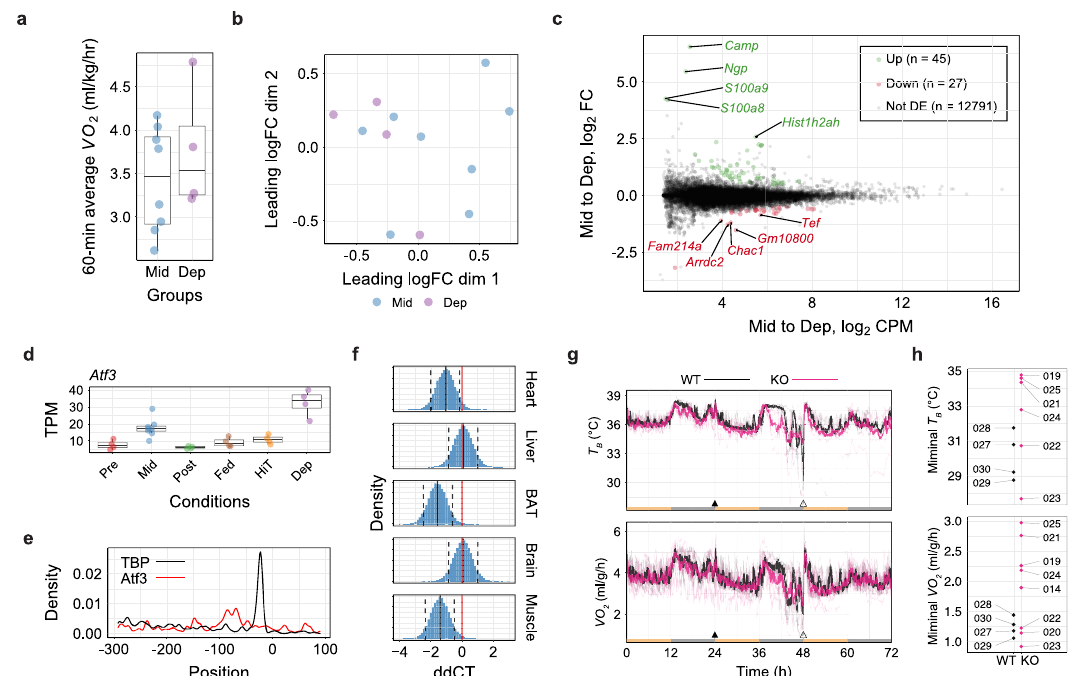
Fig. 4 Atf3 is related to FIT regulation. a Boxplots for the VO 2 of animals at sampling in the torpor deprivation experiment. Each dot represents one sample from one animal. Torpor-deprived animals (Dep group, n = 4) did not show an apparent change in VO 2 compared to the Mid group. b MDS plot of the TSS- based distance in the torpor-deprivation experiment. Each dot represents one sample from one animal. A clear separation between the Mid and Dep groups was not found in this analysis. c Distribution of CAGE clusters according to the mean TPM and the fold-change TPM of the Mid to Dep group. The top fi ve up- and down-regulated torpor-deprivation-speci fi c promoters that had annotated downstream genes are shown. d Among the torpor-speci fi c up- regulated genes, Atf3 was the only DE gene during torpor deprivation. e The motif probability of ATF3 and TBP in torpor-speci fi c promoters. f Estimated ΔΔ CT of atf3 mRNA for each organ from normal to torpid condition. The black solid line and the dashed lines denote the median and the lower and upper 89% HPDI. The red line is drawn at zero. Heart, BAT, and the soleus muscle have lower CT during torpor, which indicates higher mRNA. See Supplementary Fig. 4b for raw CT counts. g The FIT phenotype of Atf3 -KO mice ( n = 8, pink lines) was compared to wildtypes ( n = 4, black lines). The thick lines denote the average of either T B or VO 2 in each group, while thin lines show individual recordings. Atf3 -KO have a tendency of higher metabolism during torpor compared to wildtypes. h The minimal T B and VO 2 during torpor were compared between Atf3 -KO (pink) and wild-type mice (black). Two animals in the KO group failed to record body temperature due to equipment trouble. The three-digit numbers by the dots are the animal ID. Two KO lines, which showed higher metabolisms than wildtypes, ATF3-025, and ATF3-021, were selected for further